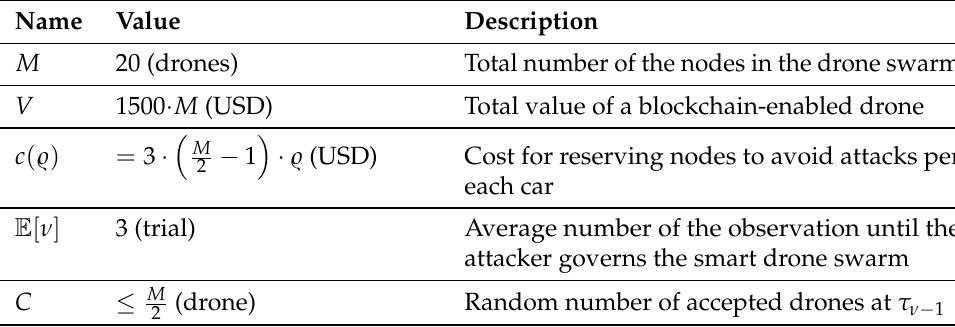
Table 2. Initial conditions for the smart drone swarm